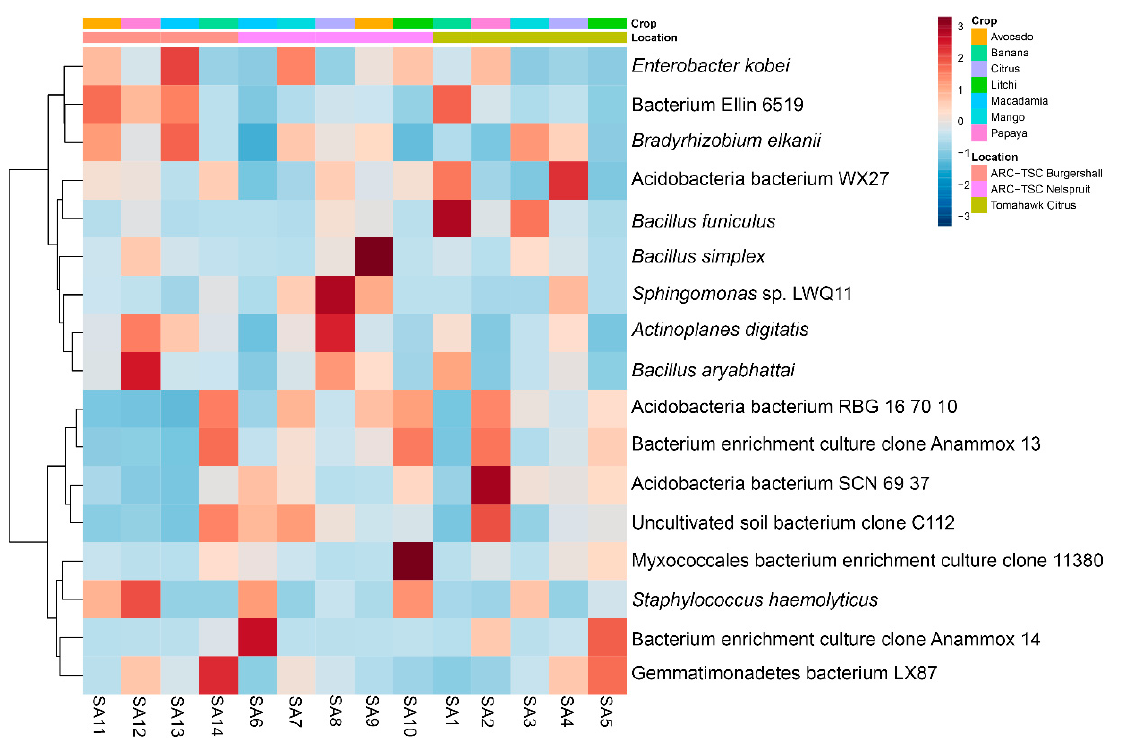
Figure 8. Hierarchical clustering illustrated by means of a heatmap and dendrogram for the 20 most abundant bacterial taxa associated with the rhizospheres of 14 orchards sampled in Mpumalanga province, South Africa.